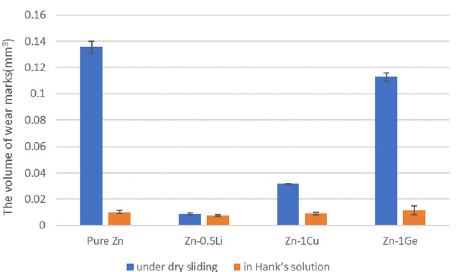
Fig. 7 Volume of wear marks of the samples under dry sliding and in Hank ’ s solution.